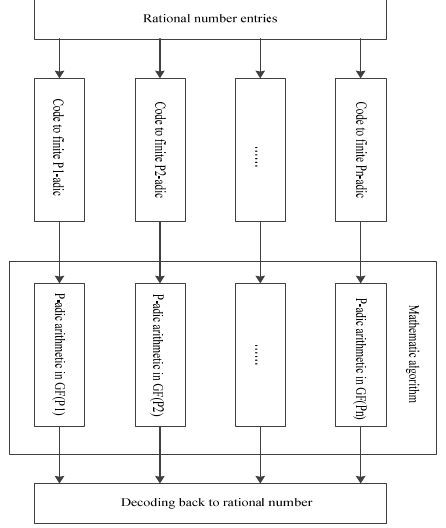
Figure 1. Extended CRT combined with P -adic arithmetic for parallel